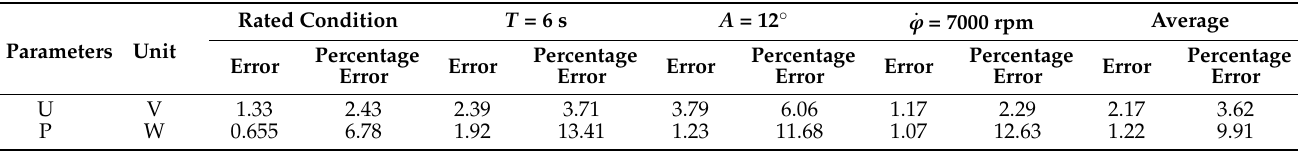
Figure 12. Comparison of experiments and simulations under different conditions: ( a ) test voltage and power under rated conditions; ( b ) simulated voltage and power under rated conditions; ( c ) test value under T = 6 s; ( d ) simulated value under T = 6 s; ( e ) test value under A = 12 ◦ ; ( f ) simulated . . ϕ = 7000 rpm; ( h ) simulated value under ϕ = 7000 rpm. value under A = 12 ◦ ; ( g ) test value under Table 4. Overall comparisons of experiment and